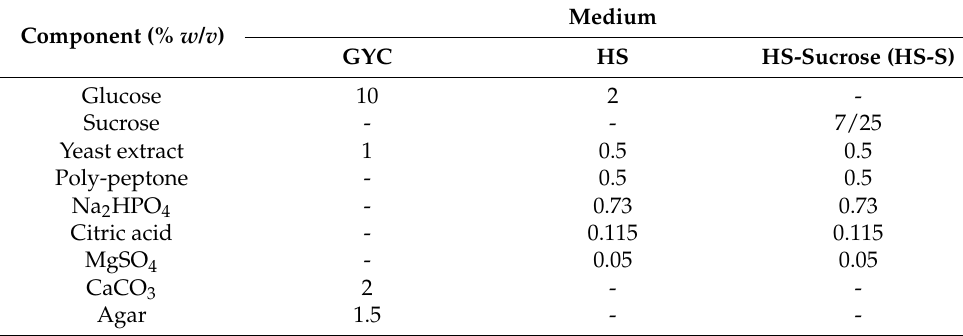
Table 2. Composition of media used in this